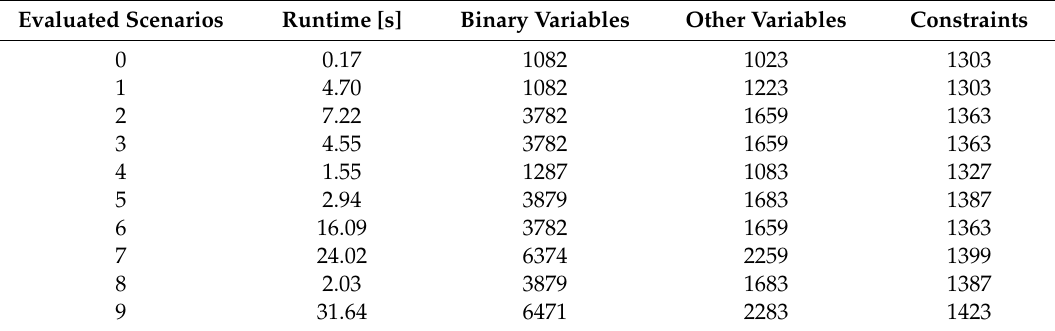
Table 3. Time, variables and constraints for each executed